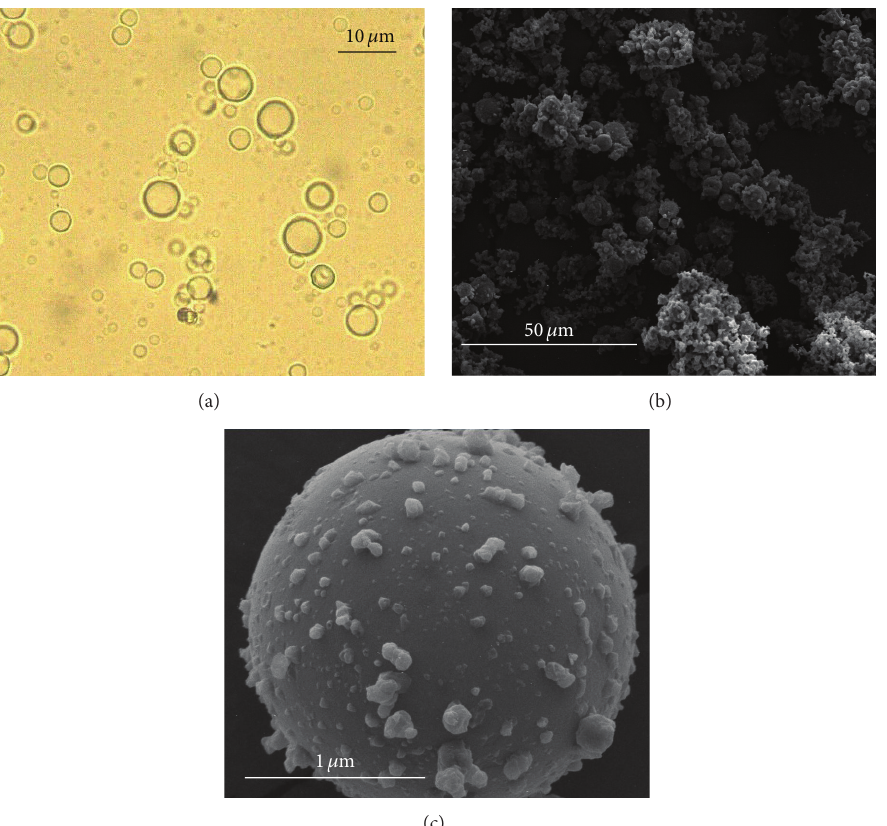
Figure 1: Representative images of microspheres formulation F6 under magnifications × 40 (a), × 2000 (b), and × 10000 (c).